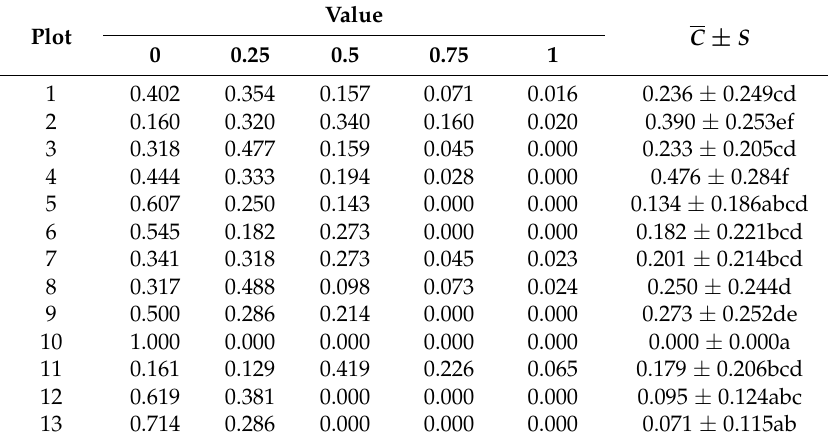
Table 6. Frequency distribution and mean value of C in different